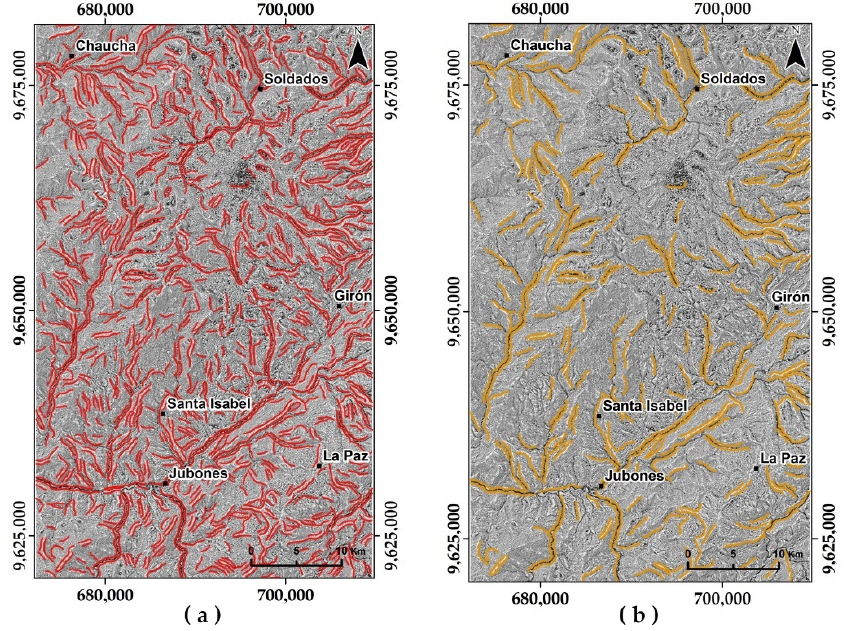
Figure 7. ( a ) Lineaments obtained with automated extraction. ( b ) Lineaments after filtering were considered lineaments of interest. Red lines are the automatic lineaments, and yellow lines are the lineaments of interest.